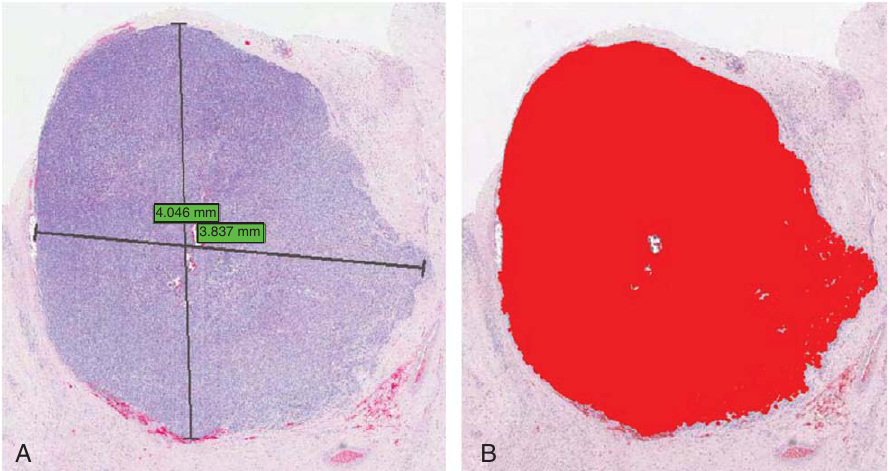
Fig. 4. Gastrointestinal stromal tumor. An H&E stained tissue section of a post-imatinib treated gastrointestinal stroma tumor was scanned into a digital slide at 40 × . Using ImageScope’s measurement tool, the two greatest maximal dimensions of a viable nodule were calculated to be 4.046mm and 3.84mm (Panel A). Two ring vectors were selected to “paint” the entire tumor nodule. The area of the “paint” was calculated to be 11.22mm 2 .